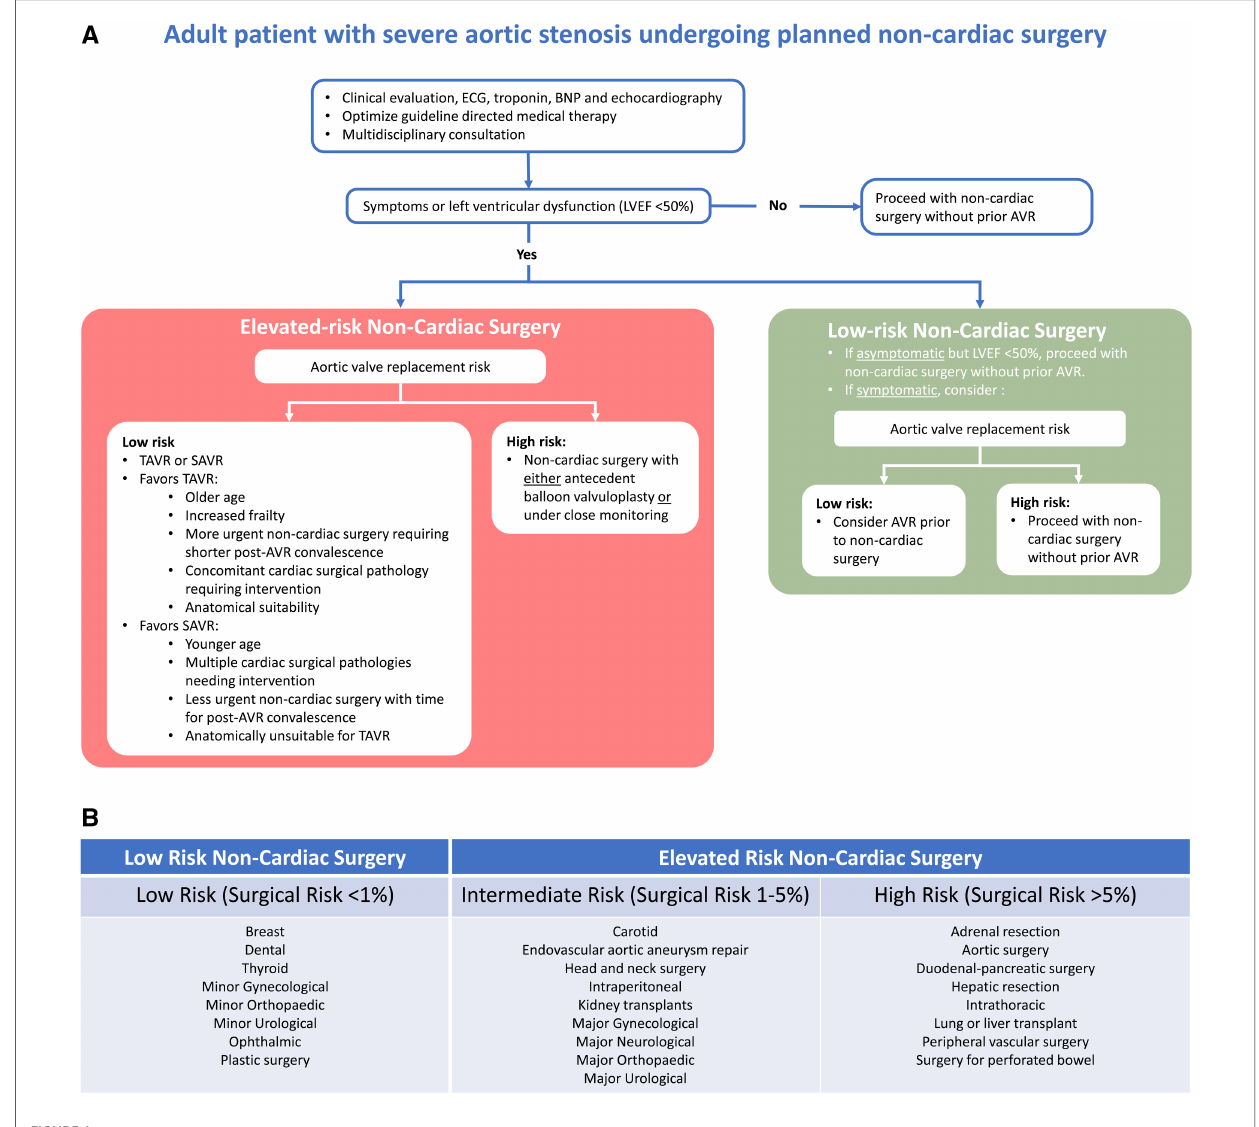
FIGURE 1 ( A ) Suggested management algorithm for patients with severe aortic valve stenosis undergoing non-cardiac surgery. ( B ) Estimated procedural risk by surgery categorized according to ACC/AHA and ESC guidelines (6, 7). AVR, aortic valve replacement; BNP, brain natriuretic peptide; ECG, electrocardiogram; LVEF, left ventricular ejection fraction; TAVR, transcatheter aortic valve replacement; SAVR, surgical aortic valve